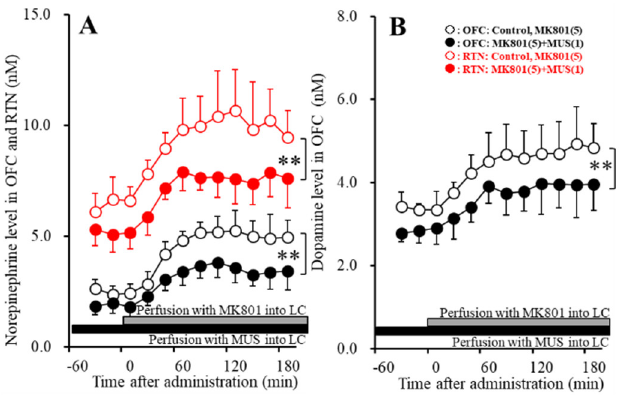
Figure 5. Effects of local administration of muscimol (MUS: 1 μM) into the LC on MK801-induced releases of norepinephrine in the OFC and RTN ( A ) and dopamine in the OFC ( B ). Ordinate: mean ± SD (n = 6) of extracellular levels of norepinephrine and dopamine (nM); abscissa: time after MK801 administration (min). Closed and gray bars indicate perfusion with 1 μM MUS and 5 μM MK801 into the LC, respectively. ** p < 0.01; relative to control by MANOVA with Tukey’s post hoc test.